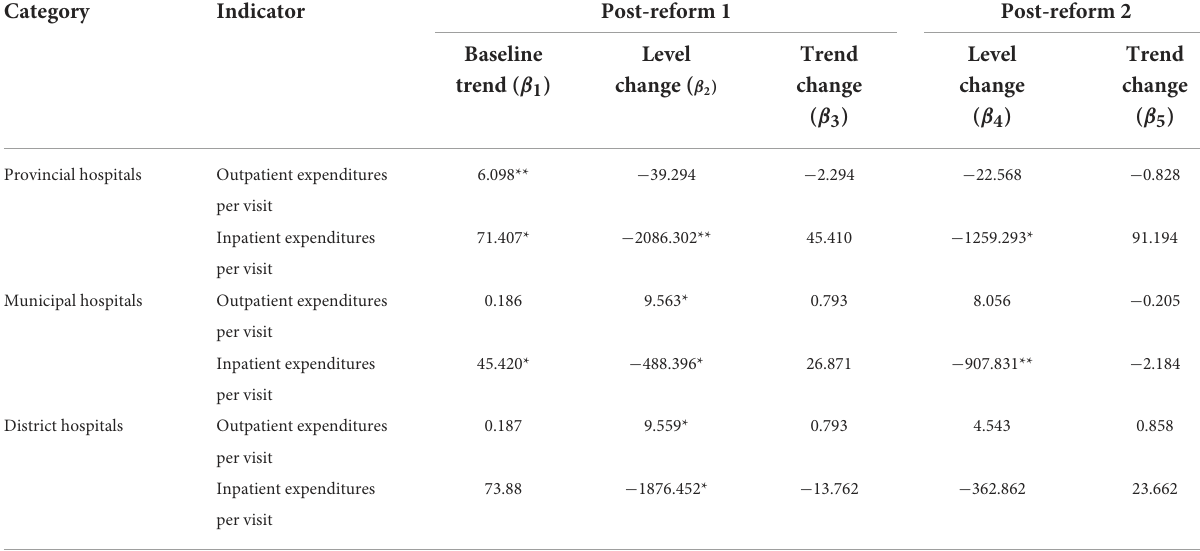
TABLE 3 Effects of reforms on outpatient and inpatient expenditures based on PITS